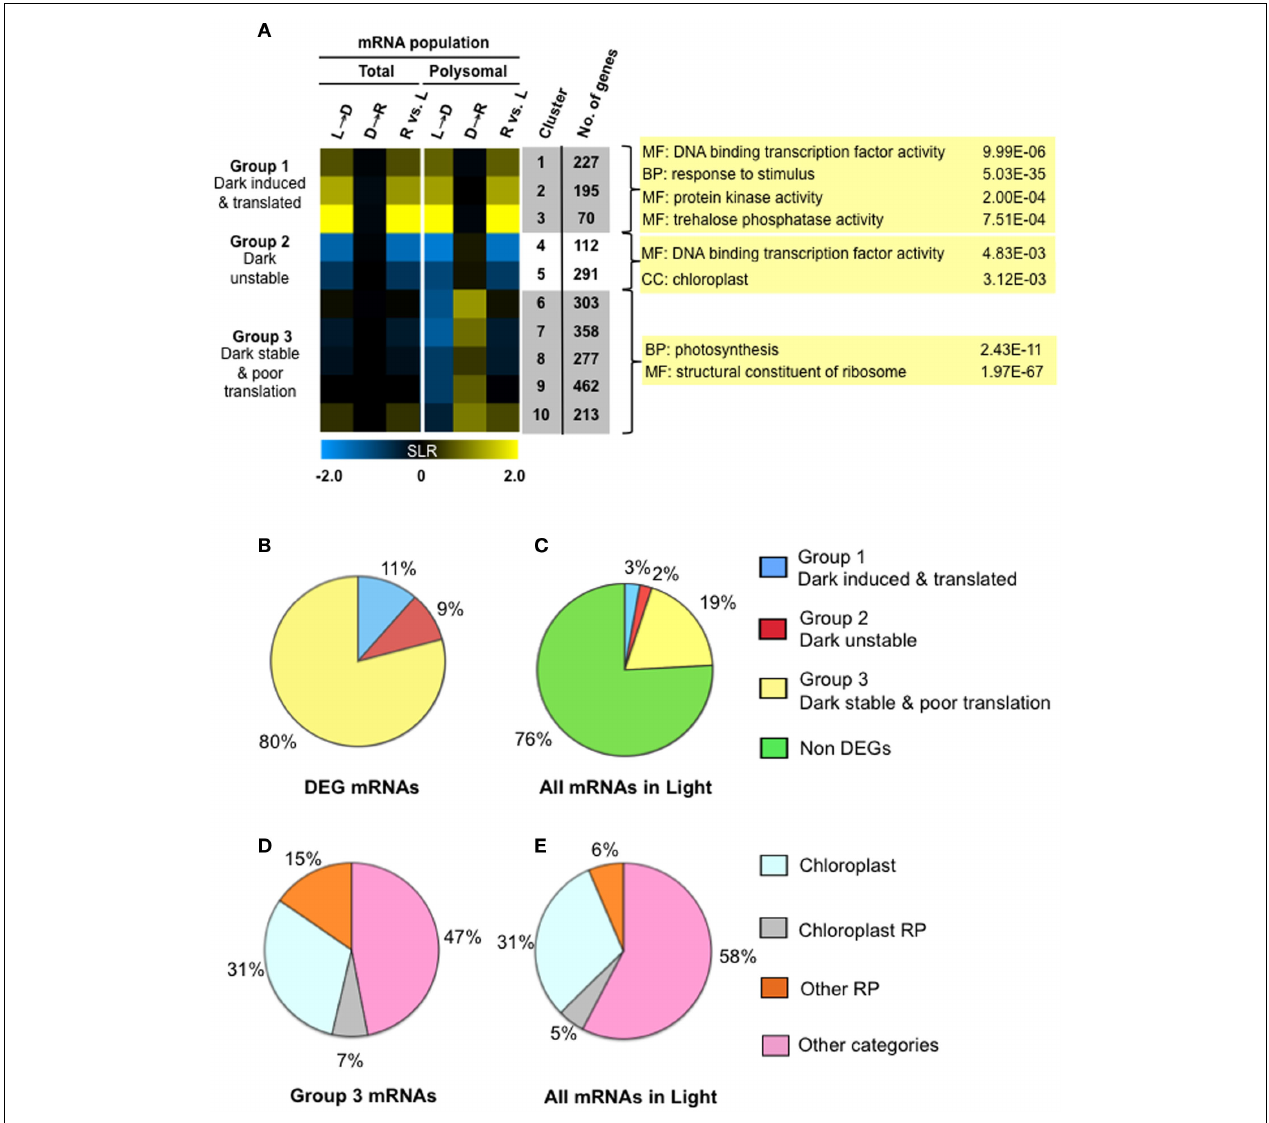
ontology (GO) categories ( p -values calculated by GOHyperGAll) from three groups of coordinately regulated genes are shown. Pie charts in (B,C) represent the percentage of total cellular mRNAs in seedlings in the light, as determined from average signal values. (B) The proportion of total cellular mRNA of contrastingly regulated gene clusters; differential expressed gene (DEG) mRNAs in groups shown in (A) . (C) Proportion of total cellular mRNA of the three groups of DEGs represented in (A) . (D) Percentage of cellular mRNA content in Clusters 6–10 (19% of the total cellular mRNA in the light) that encodes genes annotated as chloroplast localized, chloroplast ribosomal protein (RP), cytosolic, or mitochondrial ribosomal protein (Other RP) or some other category of molecular function or location. (E) Proportion of total cellular mRNA of the four classes of genes evaluated in (D)